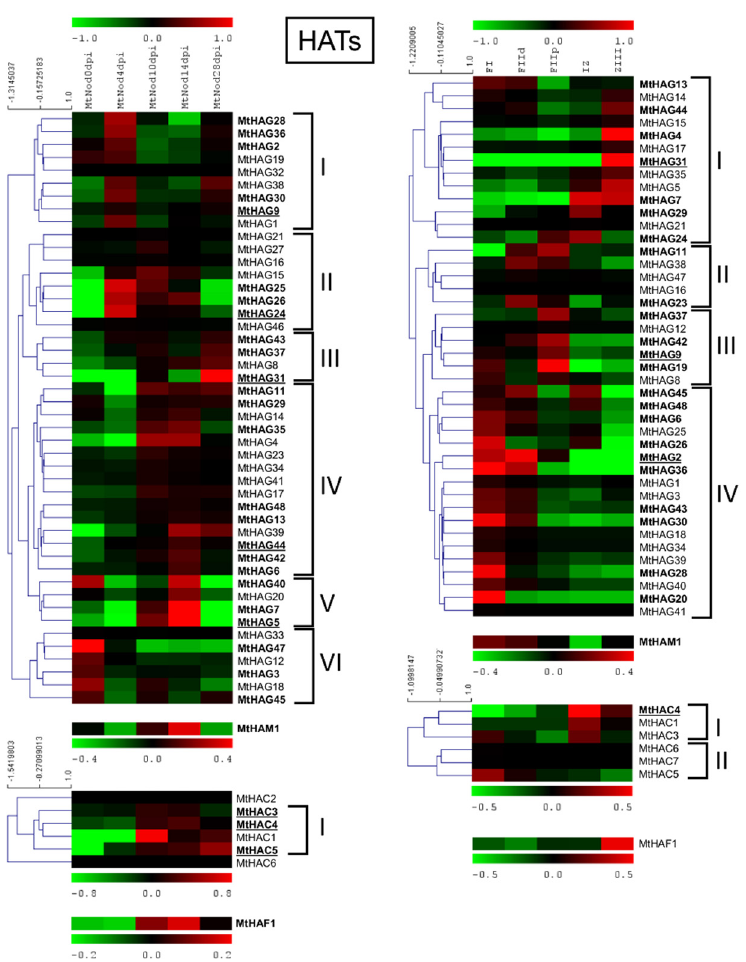
Figure 8. Heat map of MtHATs in the ND experiment (on the left) and the LCM experiment (on the right). The main clusters are indicated by square brackets. In bold are the genes with an average expression above five in the ND experiment and above two in the LCM experiment. Genes with higher expression are underlined.